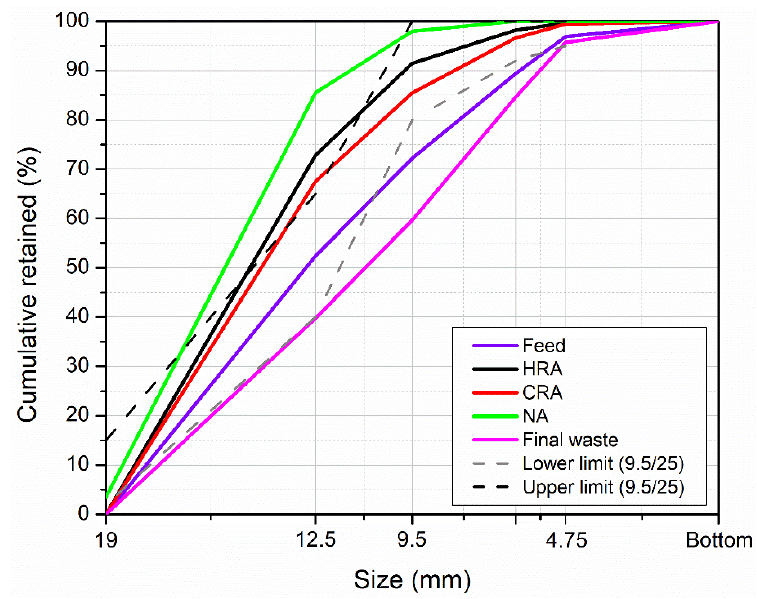
Figure 6. Size distribution curves of products compared to NA.